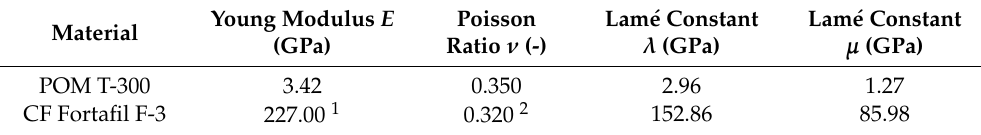
Table 5. Material properties of matrix polyethylene PE and inclusions HAp.